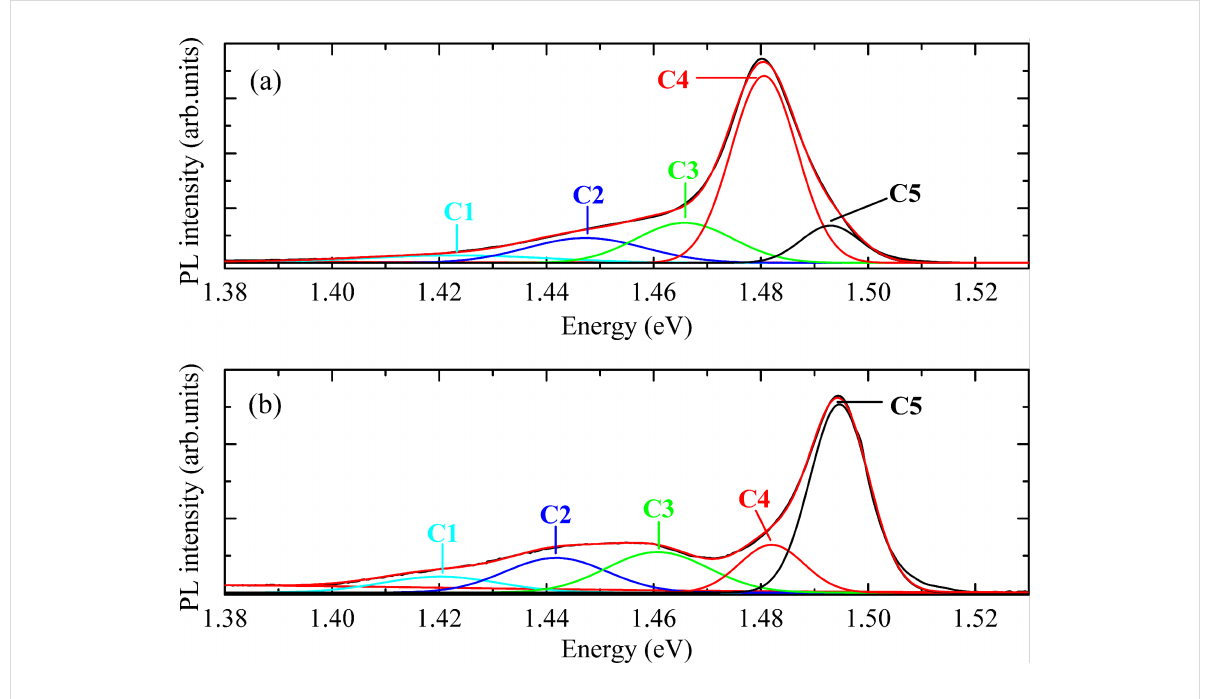
Figure 5: PL spectra of Mg-doped GaAs nanowires measured at ≈ 6 K under an excitation power of ≈ 27.7 mW, for (a) sample A and (b) sample B. The best-fit model with Gaussian components C# (# = 1, 2, …, 5) is illustrated.